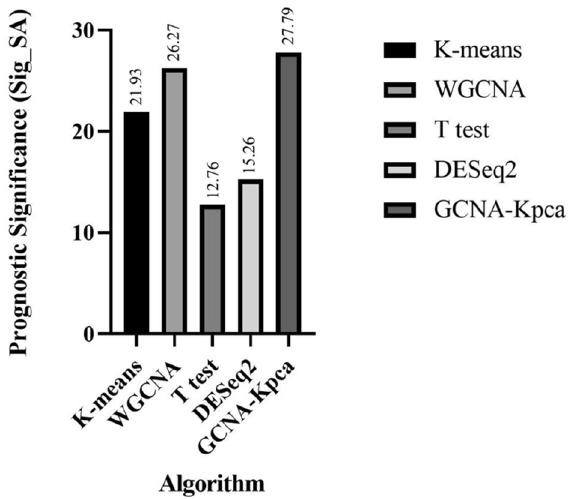
Figure 7. The prognostic significance of key genes obtained by K-means, WGCNA, T test, DESeq2 and GCNA- Kpca. This figure was drawn with GraphPad Prism 9.